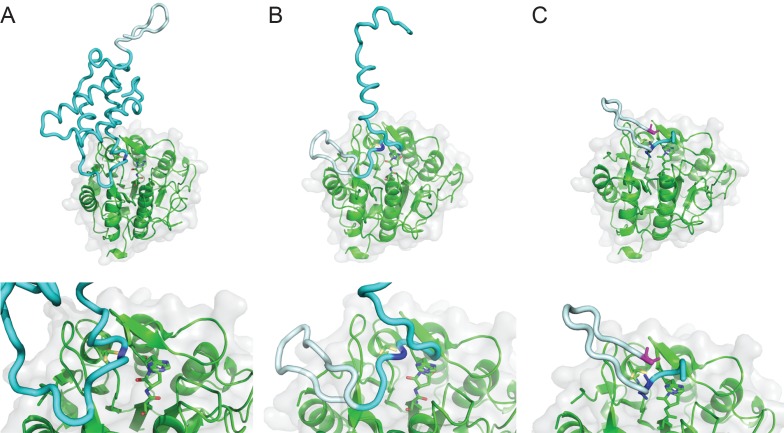
Model of SFTI-1 processing from PawS1.Model aligned on framework of tetrahedral intermediate in the active site and where the substrate should orient through the S1-S5 pocket, between the β5-β6 and βIV:βV loops, using a PawS1 NMR structure (PDB 5U87). HaAEP1 modeled PawS1 cleavage at Asn49 (A), Asn18 (B) and Asp14 (C) with expanded views of active site shown below. HaAEP1 green, SFTI-1 precursor light cyan, Preproalbumin cyan. Cleavage residues highlighted with dark blue sticks. N-terminal Gly, shown as magenta sticks, acts as nucleophile to attack C-terminus of SFTI-GLDN (C).